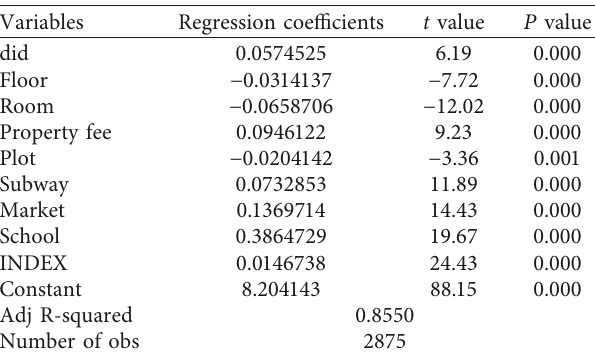
Table 3: Benchmark regression